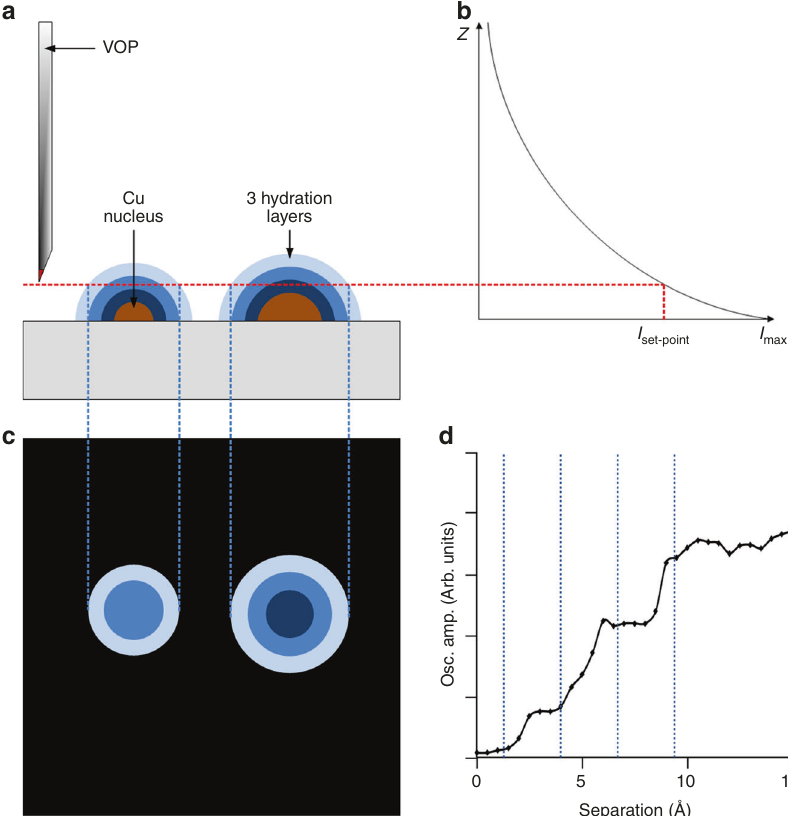
Fig. 1 Schematic of the optical feedback detection of the hydrodynamic signatures of nucleation. a Vertically oriented probe (VOP) scanned above the nascent Cu nuclei on the ITO electrode (grey). The blue gradient represents the strength of shear-force interaction around the nuclei caused by hydration layers. The red dashed line shows the scatter intensity used as the set-point to keep the probe tip at a constant separation from the ITO slide surface. b The exponential decay of the evanescent fi eld with the distance ( z- axis) from the surface of the ITO and how this relates to the intensity set-point in panel a . c Schematic representation of the contrast (probe frequency shift) induced by the shear-force interaction experienced by the tip while scanned above evolving nuclei at a given set-point. d VOP oscillation amplitude as a function of distance from a clean mica surface in ultra-pure water. This curve illustrates the hydration layer interaction in HS-LMFM